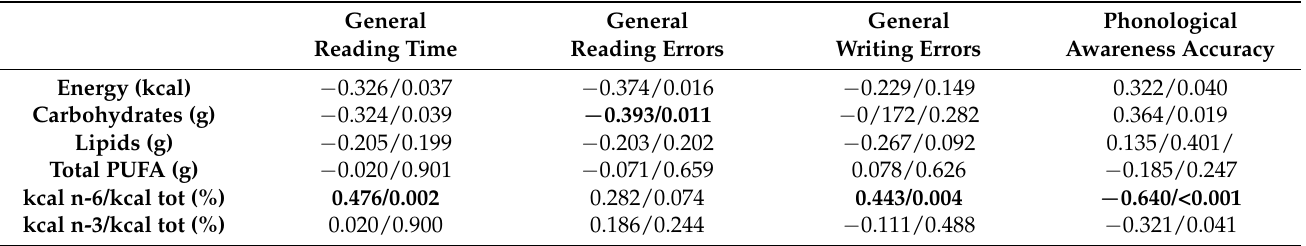
Table 4. Partial correlations (controlling for age) between nutritional information and read- ing/writing/phonological processing measures ( n = 42, alpha = 0.017). Reported values are Pearson’s correlation index r/ p -value. In bold, significant